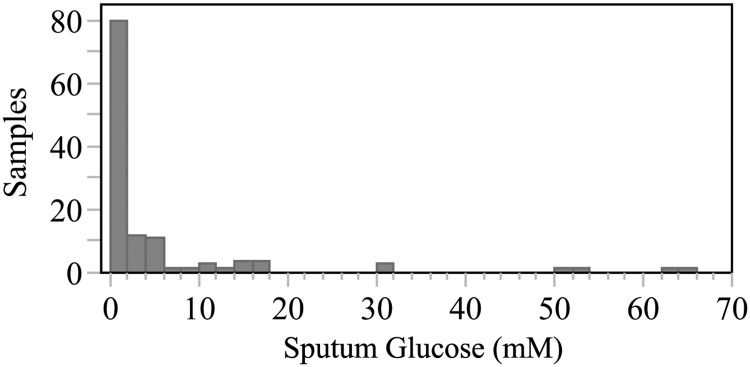
Distribution of sputum glucose concentration in 117 samples.Sputum glucose (SG) was much lower than previously reported, with 34% reading < 0.01 mM, and 55% of samples reading < 1.0 mM. The distribution of SG was highly skewed: the median concentration was 0.7 mM (IQR, 0–3.5 mM) versus the mean of 4.75 mM (SD 11.4 mM).